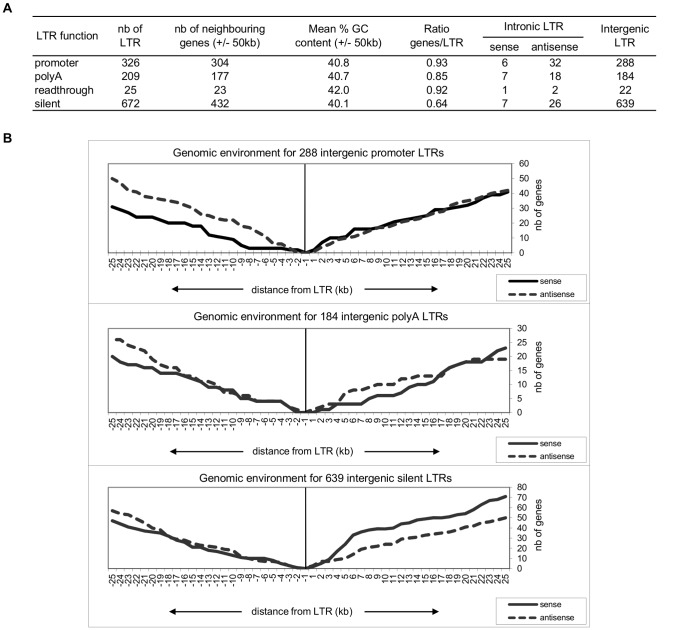
Genomic environment of functional and silent LTRs.(A) Overview of genomic and chromatin composition (%GC) of functional LTR neighborhood. For all promoter, polyA, readthrough and silent LTRs, the number of neighboring genes in the surrounding +/−50 kb is obtained from NCBI 36/hg18 using annotations from the RefGene table (UCSC), then the DNA sequences are extracted in silico for %CG content calculation. The table includes the number of intronic functional LTRs, defined as LTRs that overlap gene limits (NCBI 36/hg18 RefGene table), and ends with the number of intergenic LTRs. Sense: LTR and gene are in the same orientation; antisense: LTR and gene are in opposition. (B) Genomic environment for intergenic functional LTRs. Genes in the same orientation (sense) or in opposition (antisense) with the LTRs are counted in the case of promoter, polyA and silent intergenic LTRs. Read-through LTRs are not included as their number, which is too low, does not fit with the representation. Vertical bar centered on zero should be interpreted as an ellipse of the LTR sequence. Away from the bar, the cumulative gene occurrence is shown up to +/−25 kb starting from the LTR limits. Curve tendencies beyond 25 kb do not change significantly and are not represented.